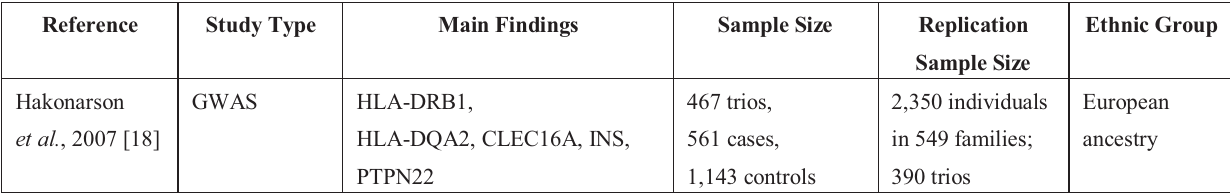
Table 1. T1D susceptibility loci identified to